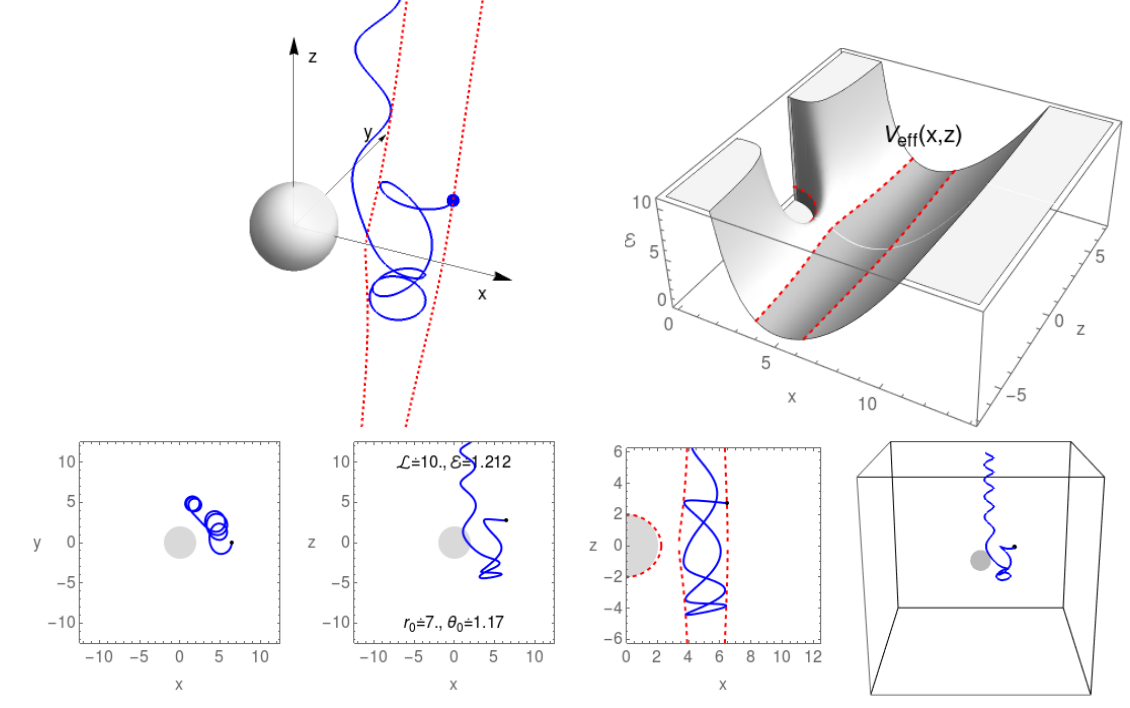
Figure 4. Charged particle escaping from BH with uniform magnetic filed, for detailed description see Figure